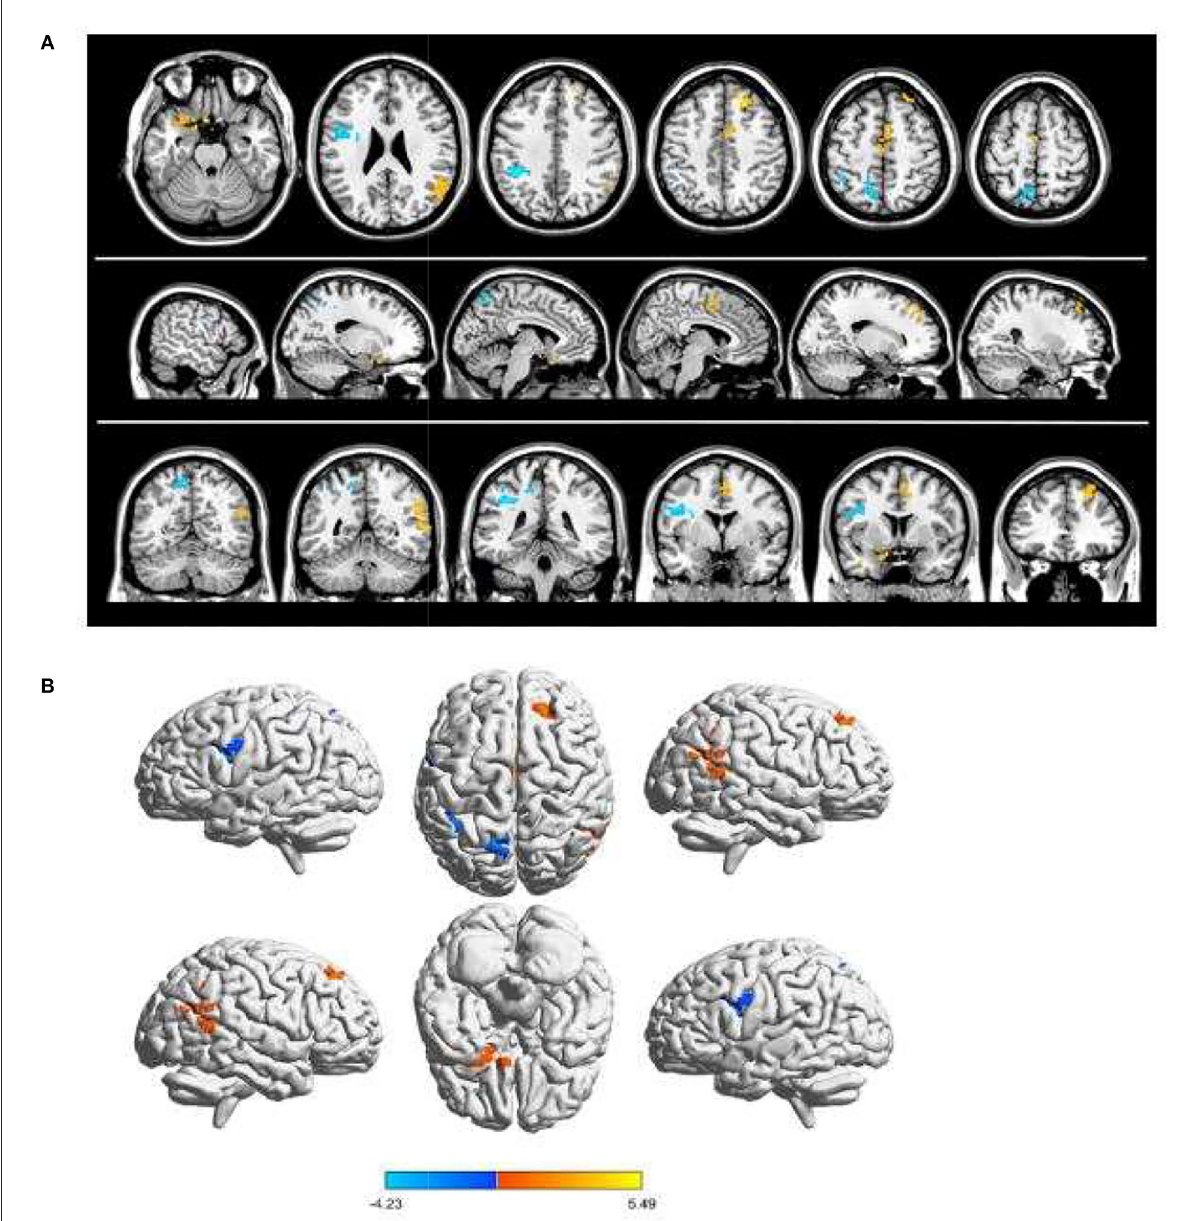
FIGURE1 Spontaneous brain activity in children and HCs. (A) The brain regions presented sensible differences in fAlFF values between SA and HCs. (B) Children with SA would be observed some abnormal brain activities in specific regions. Compared with HCs, red regions trend to mean higher fALFF values. Regions marked by blue presented delegated regions presenting decreased fALFF values. fALFF, fractional amplitude of low-frequency fluctuation; HCs, healthy controls; SA, strabismus and amblyopia.